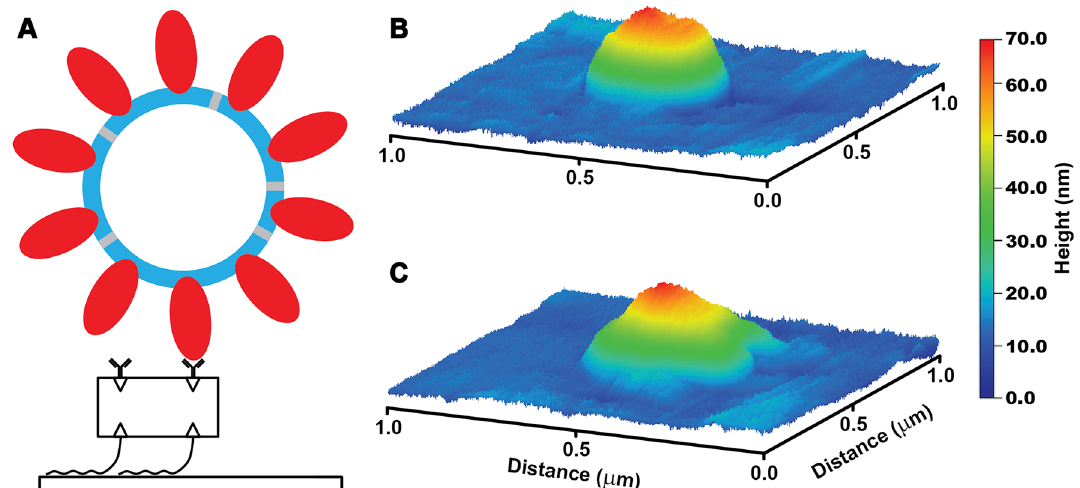
Figure 3. VLP surface immobilization and imaging. ( A ) Schematic of VLP-surface attachment strategy (bottom to top): glass surfaces were functionalized with Biotin-PEG-Silane, then neutravidin, then biotinylated anti-S antibody which then allowed for the capture of purified VLPs. VLP imaging showed initially symmetric particles. ( B ) which developed prominent deformations likely indicative of bursts upon repeated AFM imaging with 1 nN peak force ( C